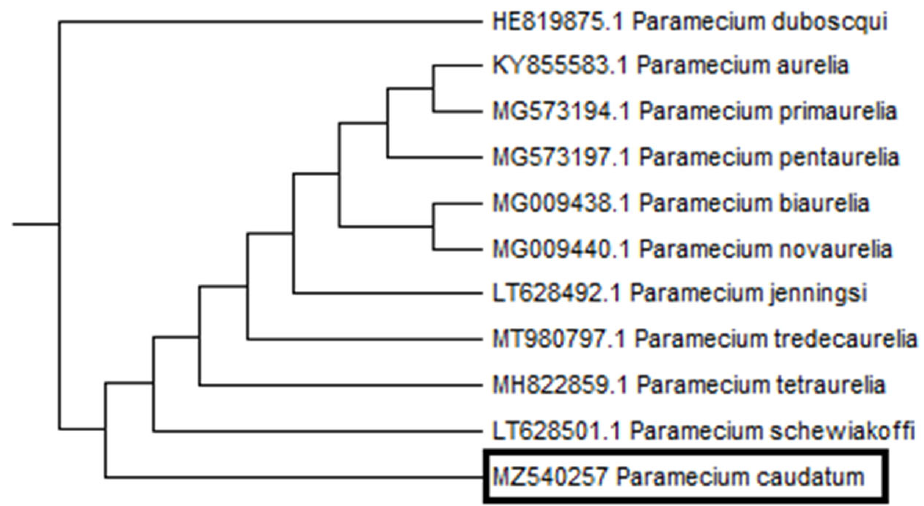
Figure 1. Lane 1, 1kb molecular weight marker; lane 2, PCR amplification of 18S rRNA gene of ciliate UR03 isolated from industrial wastewater.